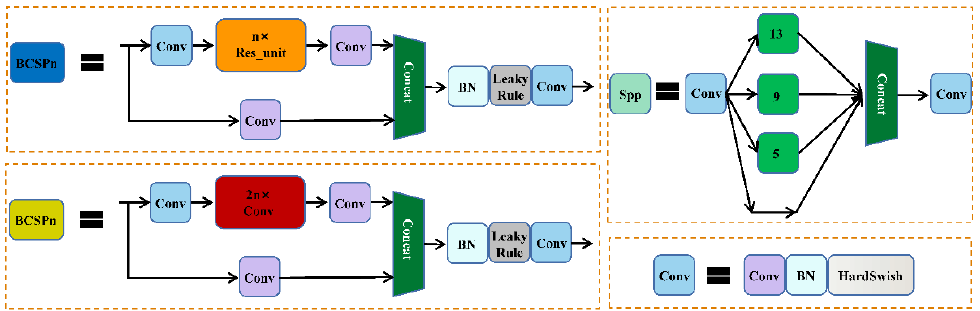
Figure 3. BCSP and SPP structure diagram.